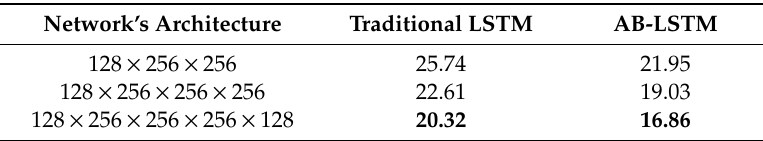
Table 3. EER (%) results of the different network’s architectures in a clean background environment.